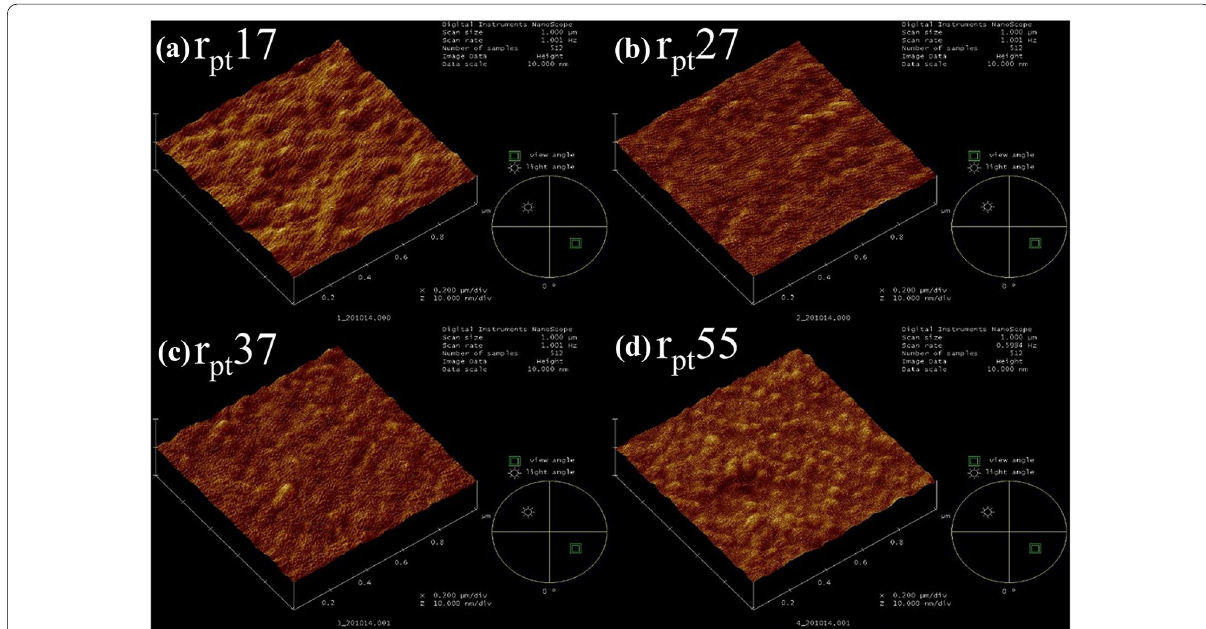
Fig. 3 AFM images of HZO surfaces on various Pt substrates. The information in the inside panels includes scan size, scan rate, and data scale. The surface root‑mean‑square roughness (R RMS ) of the HZO films was approximately 0.5 nm for all samples